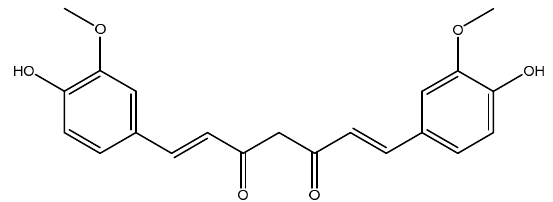
Figure 10. Chemical structure of curcumin.